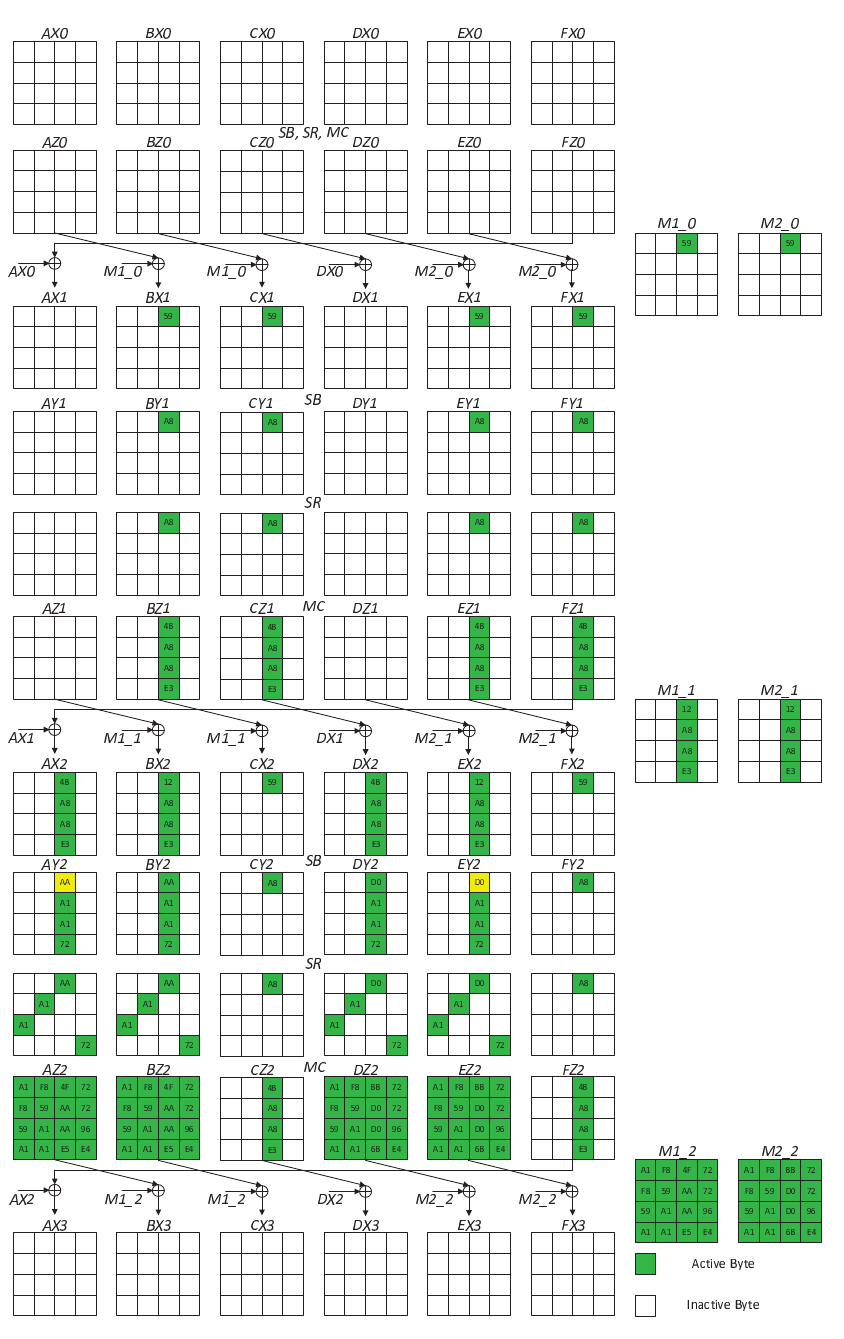
Figure 5: Valid differential characteristic for